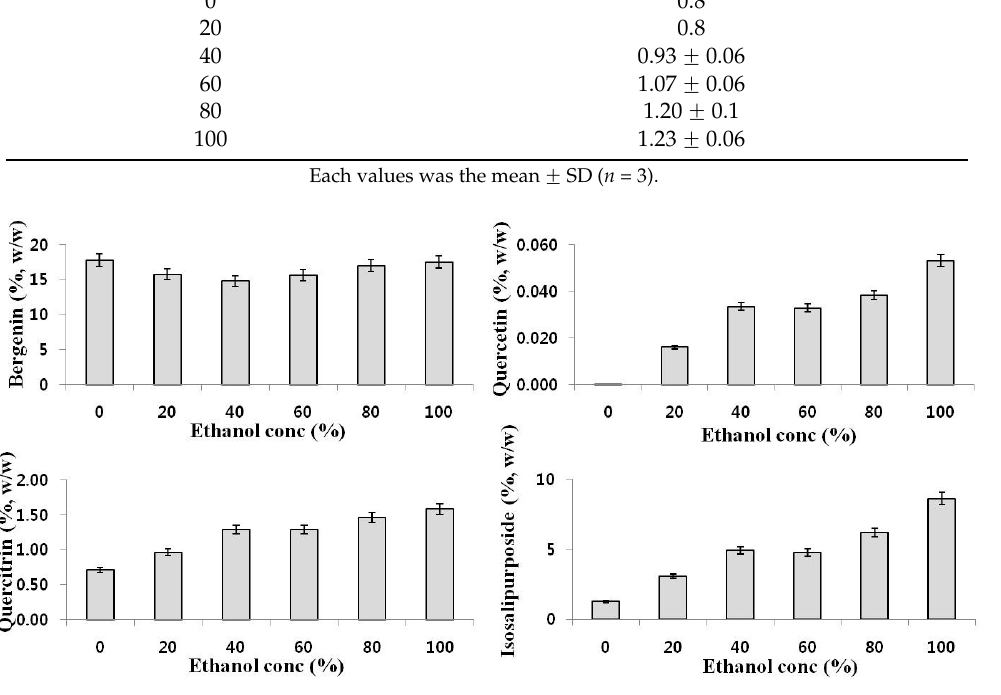
Figure 2. Concentration of bergenin, quercetin, quercitrin and isosalipurposide in ethanolic extract from C. coreana Uyeki flos. Each value was the mean ± SD ( n = 3).